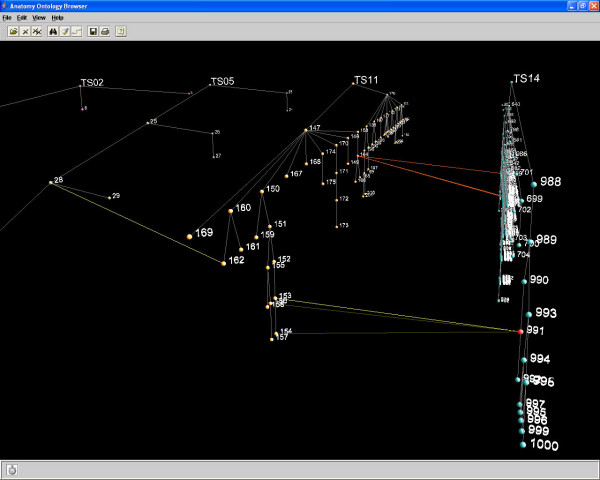
Relationships spanning data sets in the 3D browser. Colour-coded links are drawn between three DAGs to show relationships across stages, functionality that can also be used for tracing lineage.